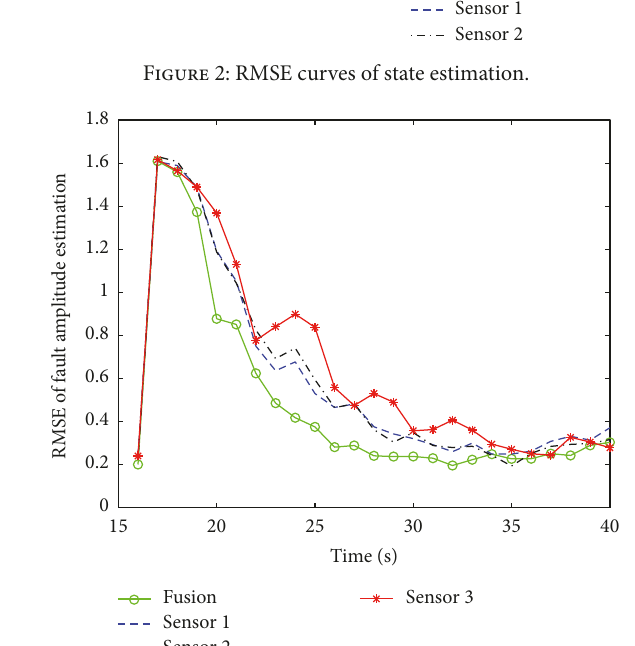
Figure 2: RMSE curves of state estimation.